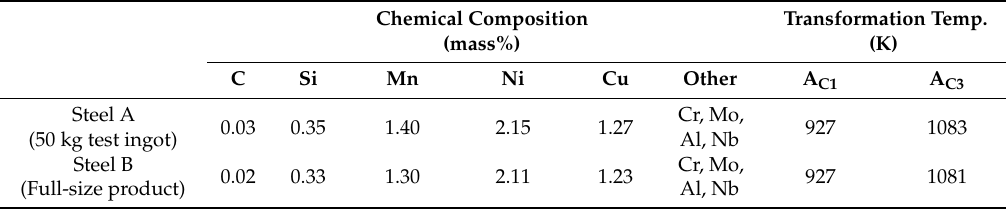
Transformation Temp. (K)